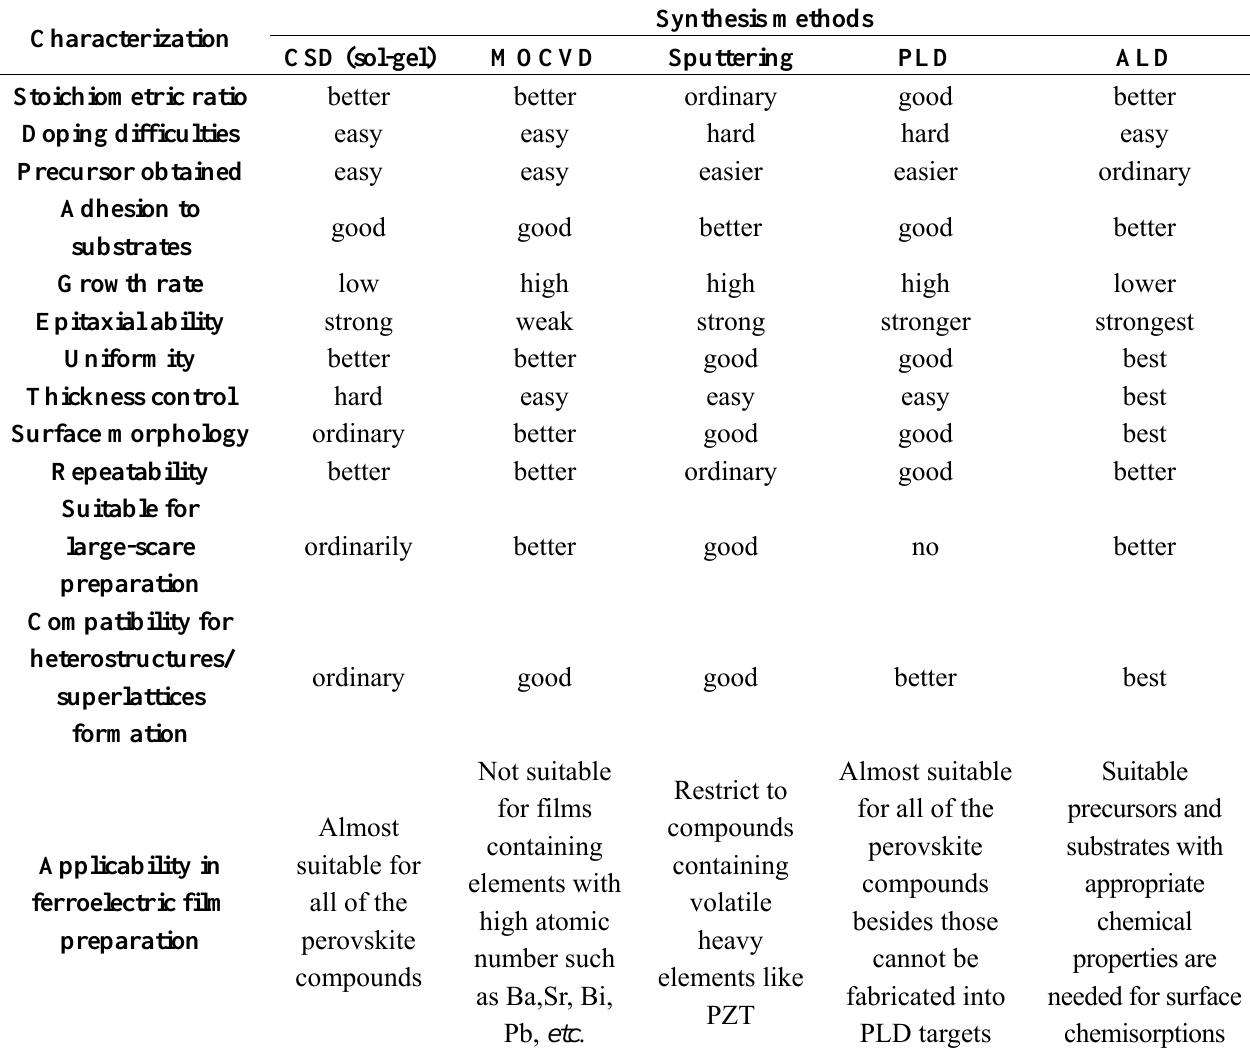
Table 2. Comparison of five mainly synthesis methods for ultrathin ferroelectric